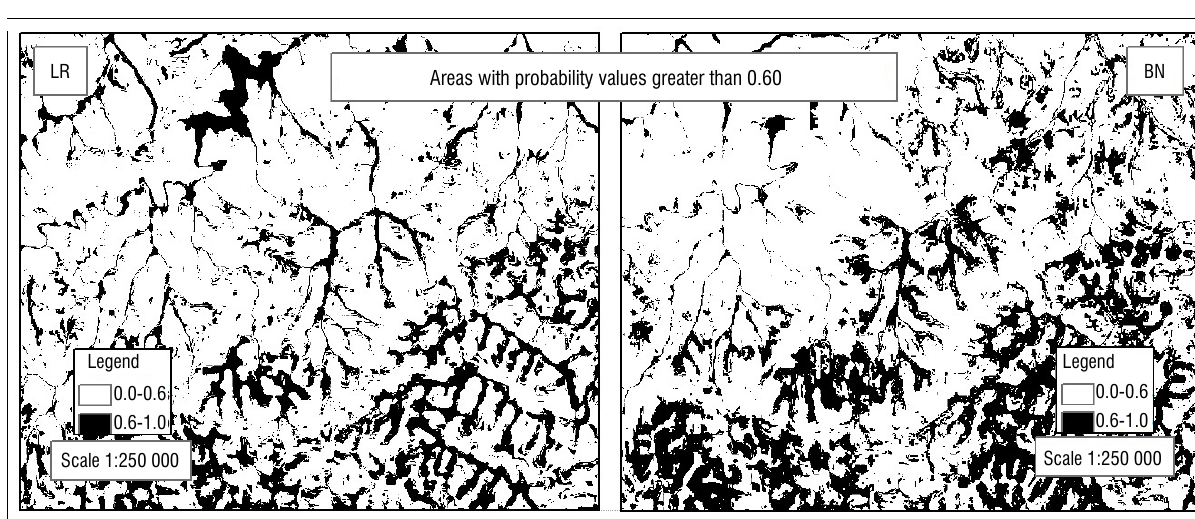
Model validation and assessment Table 4: Percentage area of KwaZulu-Natal covered by wetlands at different probability value thresholds as determined by the Results from the ROC curves indicated that the AUC for the predicted logistic regression and Bayesian network models probabilities of the BN model and LR model were 0.853 (SE=0.00287; 95% confidence level = 0.847–0.858) and 0.840 (SE=0.00301; 95% Area covered (%) confidence level = 0.835–0.846), respectively (Figure 6). An AUC of 1 Probability threshold indicates perfect prediction, whereas an AUC of 0.5 indicates completely random binary prediction. Although there was a marginal difference in the AUC results for the BN and LR models, the difference was not pronounced enough to conclusively state that one model has outperformed the other in predicting wetland occurrence. ROC analyses were performed using the test wetland data set to compare the predicted probabilities derived from a simple binary LR to the derived and predicted probabilities from the BN. The ROC analyses performed on the BN probability layer and the LR probability layer indicated that both models predicted the occurrence of wetlands relatively similarly 51 (Figure 6). The ROC analysis determined that the criterion model probability threshold for both models (at which probability both the sensitivity (71.6) and specificity (81.2) are the highest as a pair) was greater than 0.60; i.e. if the probability values in both layers were split into binary classes of wetland and non-wetland areas, then 0.60 would be the ideal split to maintain good predictability of wetland and non-wetland occurrence.